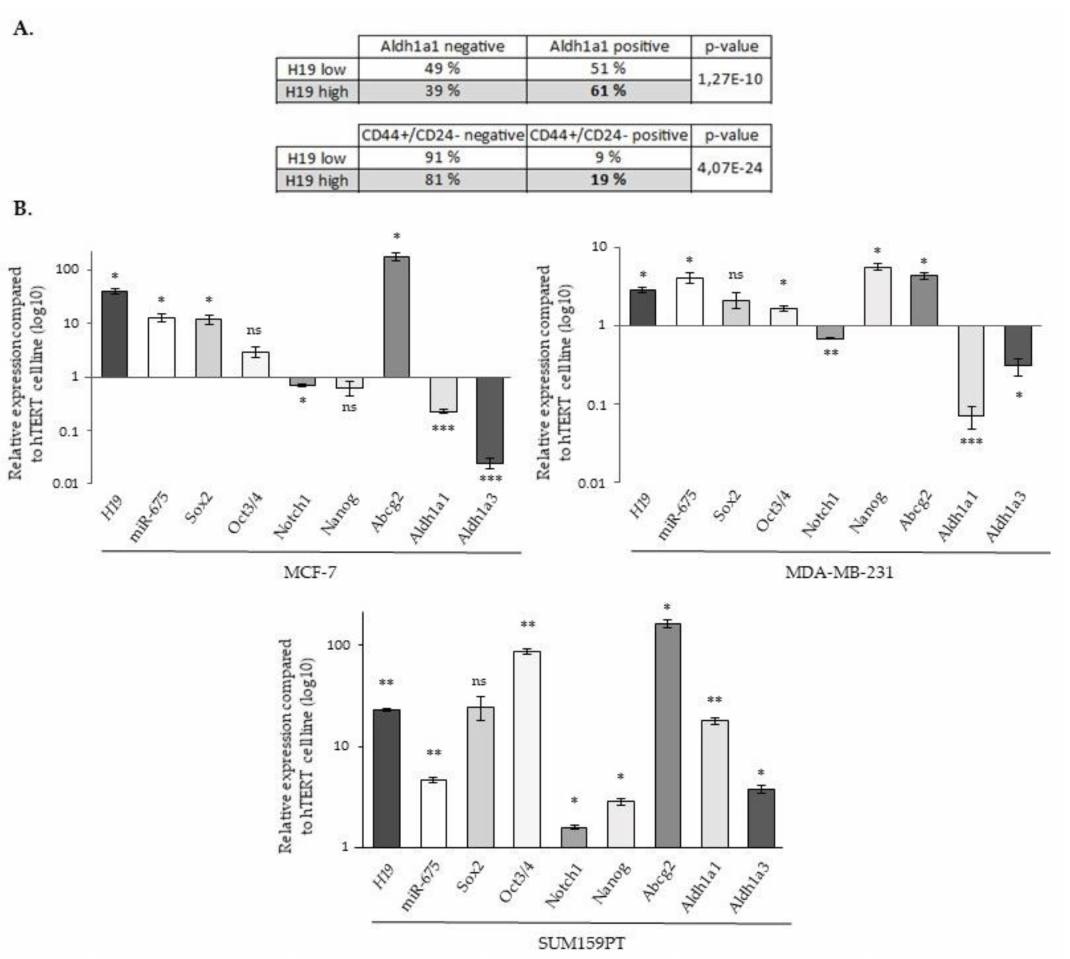
Figure 6. The expression of H19 , miR-675 and di ff erent stem cell markers. ( A ) The expression of the H19 gene in mammary tumors expressing or not stem cell signatures. The table represents the H19 gene expression dependent on the gene signature of the tumors. Two gene signatures were used, one obtained in cell expressing ALDHA1 and the other in CD44 + / CD24 - . ( B ) The relative expression of H19 , Sox2 , Oct3 / 4 , Notch1 , Nanog , Abcg2 , Aldh1a1 and Aldh1a3 genes and miR-675 in MCF-7, MDA-MB-231 and SUM159PT cells. The expression levels were related to the expression levels in hTERT cells indexed to 1. For panel A, a Fisher’s exact test was performed. * p < 0.05; ** p < 0.01; *** p < 0.001; ns: not